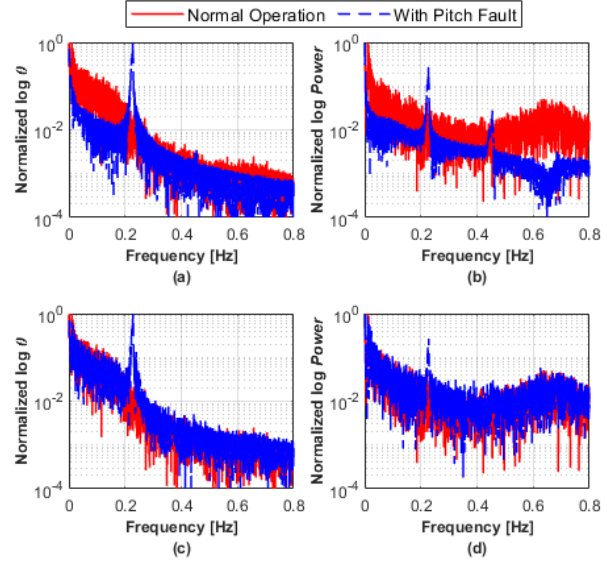
Fig. 7. Frequency domain of the pitch fault of 4 ◦ for (a) normalized pitch angle ( θ ) without turbulence, (b) normalized shaft power without turbulence, (c) normalized pitch angle ( θ ) at the turbulence intensity of 10 %, and (d) normalized shaft power at the turbulence intensity of 10